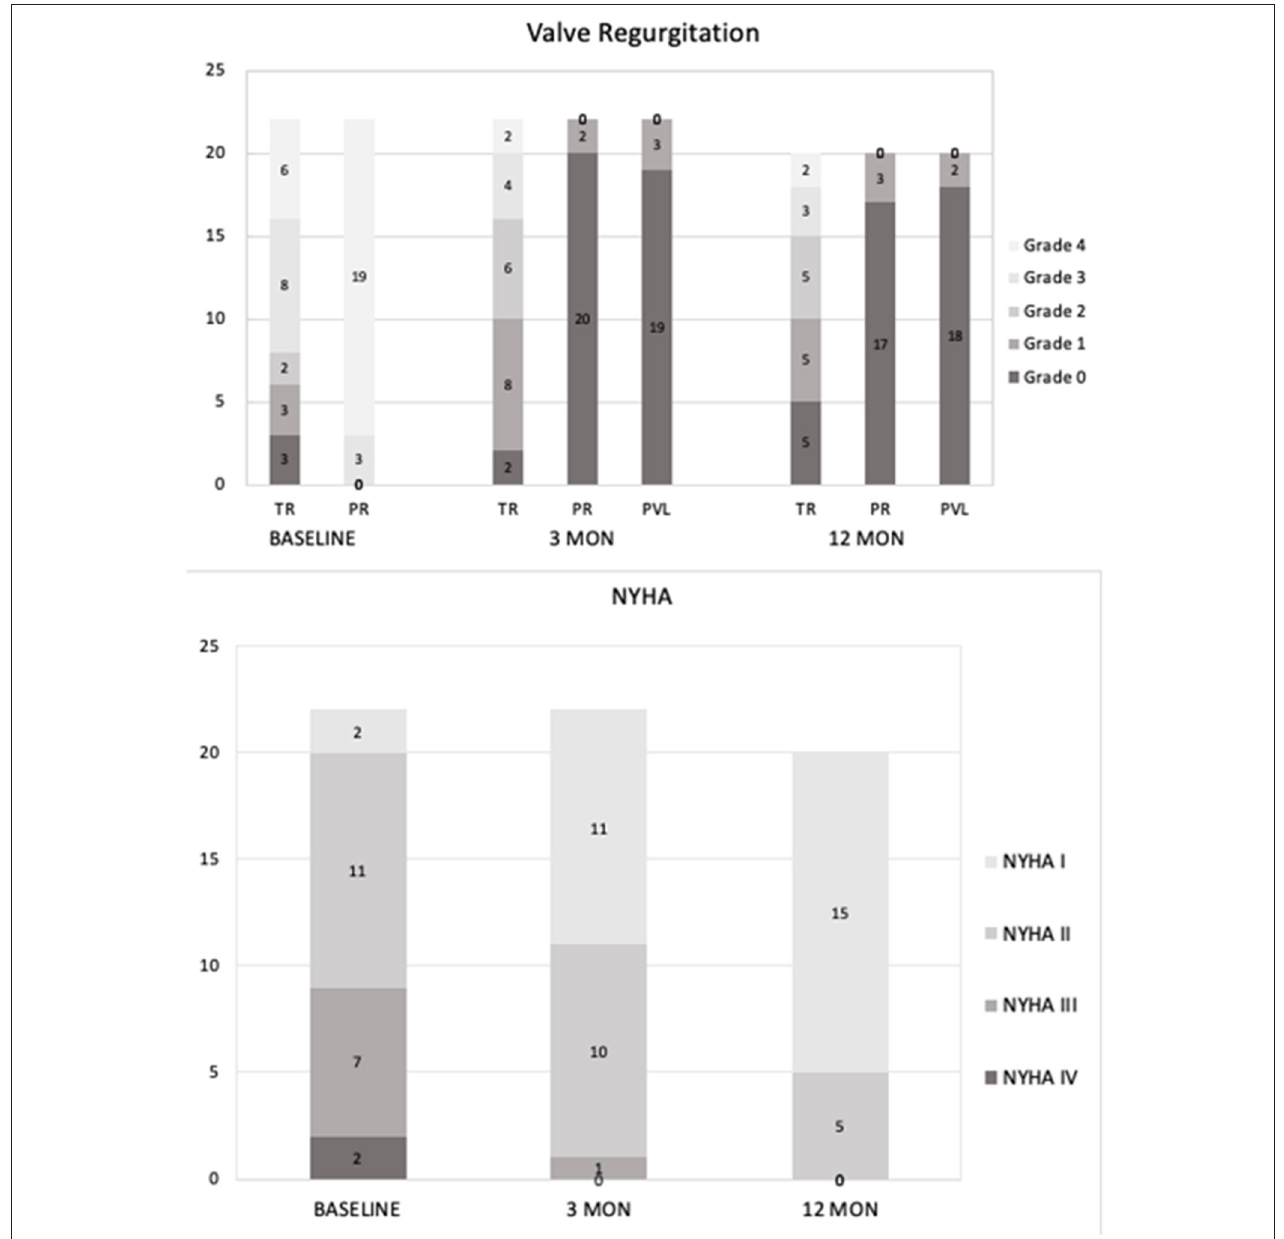
FIGURE 3 | Follow-up data after PT-Valve implantation. Upper panel: Tricuspid regurgitation, pulmonary regurgitation, and transcatheter pulmonary perivalvular leakage at baseline, 3-months and 1-year follow-up. Lower panel: The distributions of NYHA classification at baseline, 3-months and 1-year follow-up.